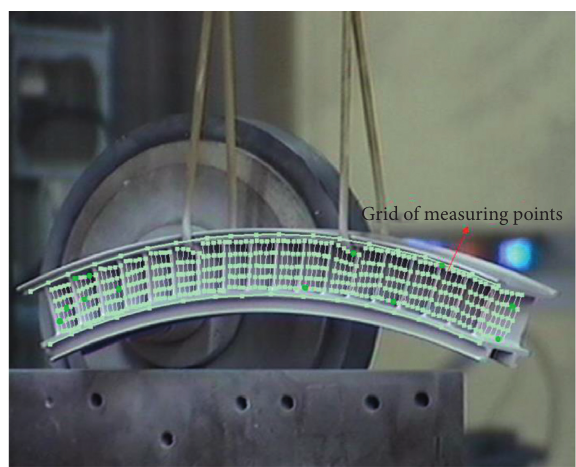
Figure 4: Measurement points used in the